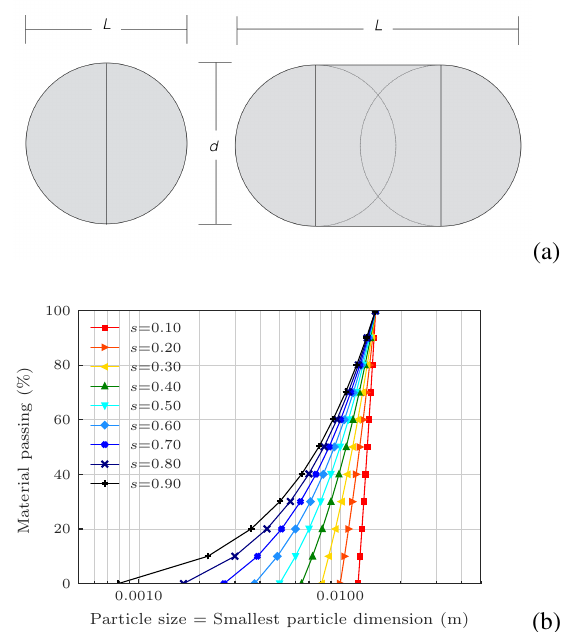
Figure 1. (a) Rounded-Cap-rectangle with aspect ratio  = L / d = 1 (disc) and  = L / d > 1 (Rounded-Cap-Rectangle). (b) Particle size distribution of tested samples, with uniform solids volume by particle size. The colors illustrate the di ↵ erent val- ues of size-span used s . The limits s uniform and very well graded samples,